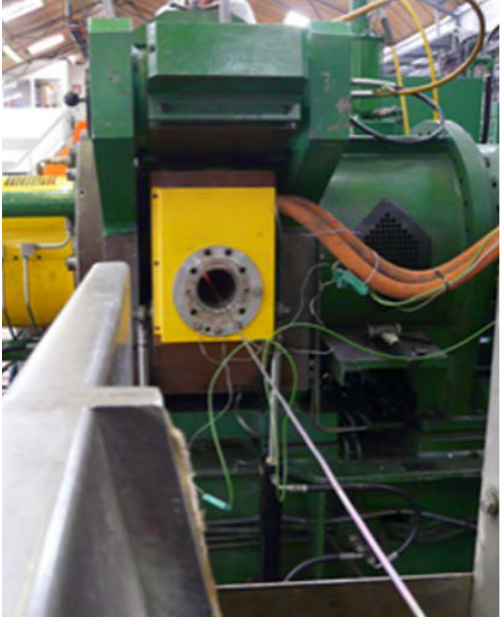
Figure 5. Photograph of the titanium alloy wire being extruded from the Conform TM machine. The wire glows white / red as it emerges from the back of the extrusion die in the centre of the photograph. Table 1. Geometries of the tooling used in the trials and the abutment materials used. Trial